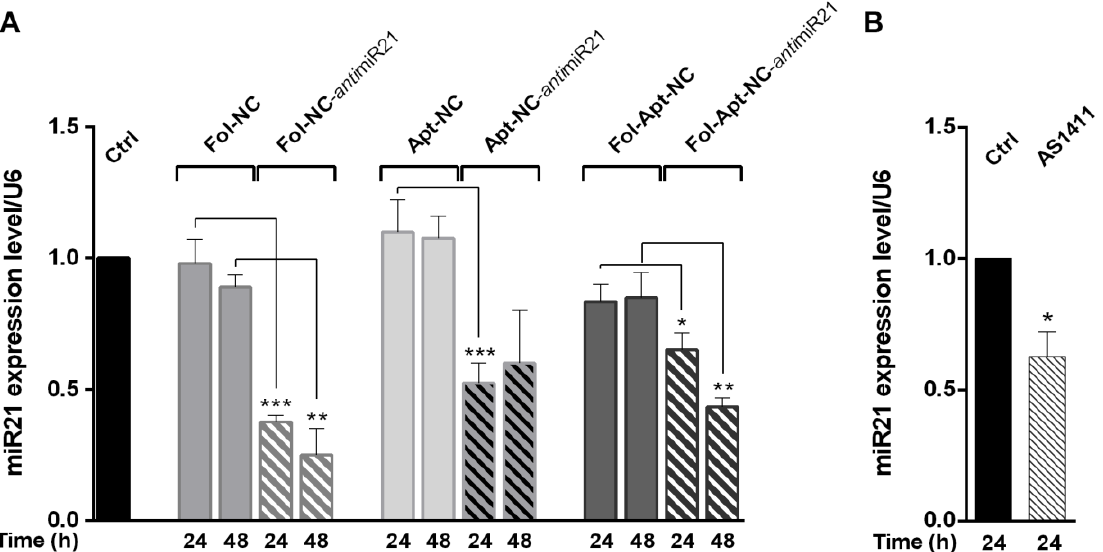
Figure 2. MiR-21 silencing activity of folate and AS1411-functionalized nanocages in MDA-MB-231 cells. ( A ) qPCR analysis of miR-21 expression level after treatments of MDA-MB-231 cells for 24 and 48 h, with different DNA nanocages carrying sequences complementary to miR-21 (antimiR21) or with non-relevant DNA sequences as negative control. ( B ) miR-21 expression level after treatment of MDA-MB-231 cells with 10 µ M free AS1411. Values are expressed as mean ± S.E.M. of three different independent experiments. Statistical significance: * p < 0.05, ** p < 0.01, and *** p < 0.001 (ANOVA test).